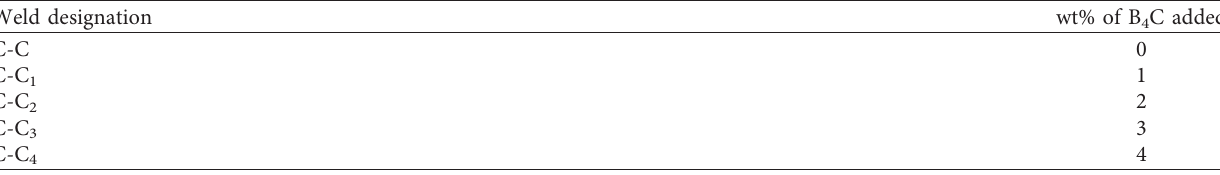
Table 3: FSW welds with B